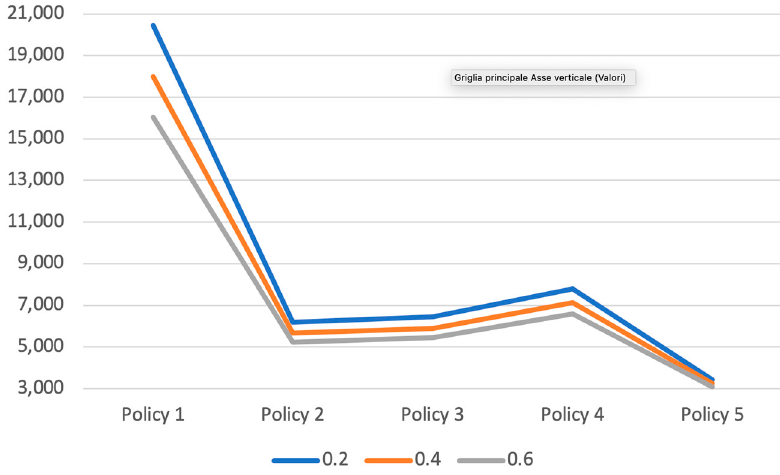
Figure 4. Number of on/off activities.